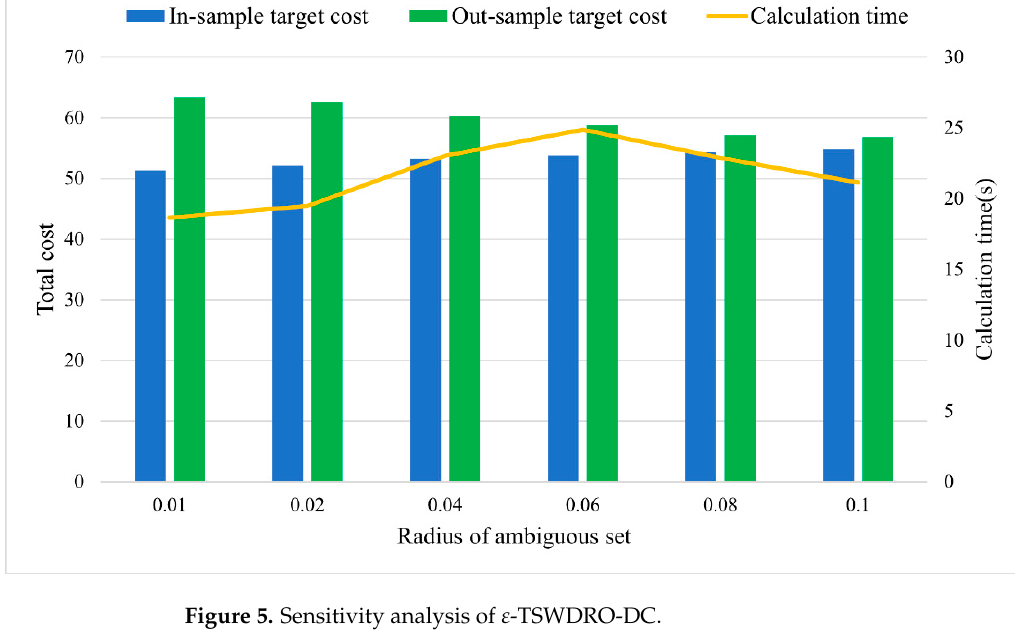
Figure 4. Sensitivity analysis of TSWDRO-DC.